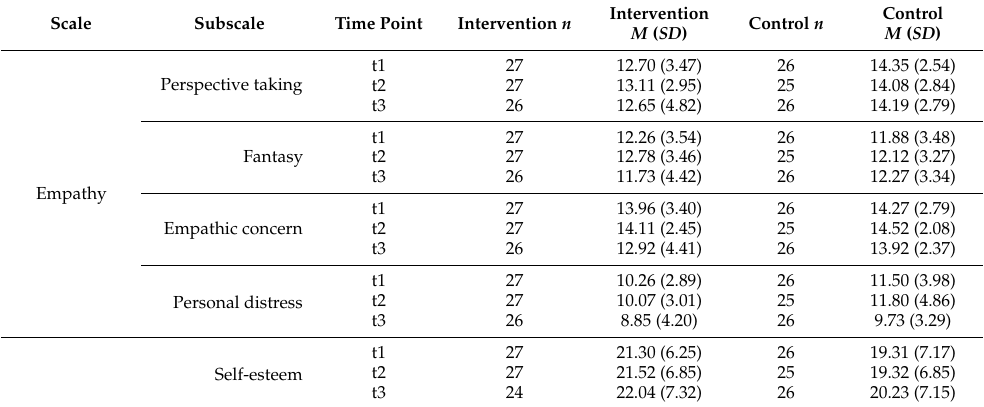
Table A1. Development of secondary outcomes over time for the intervention and the control